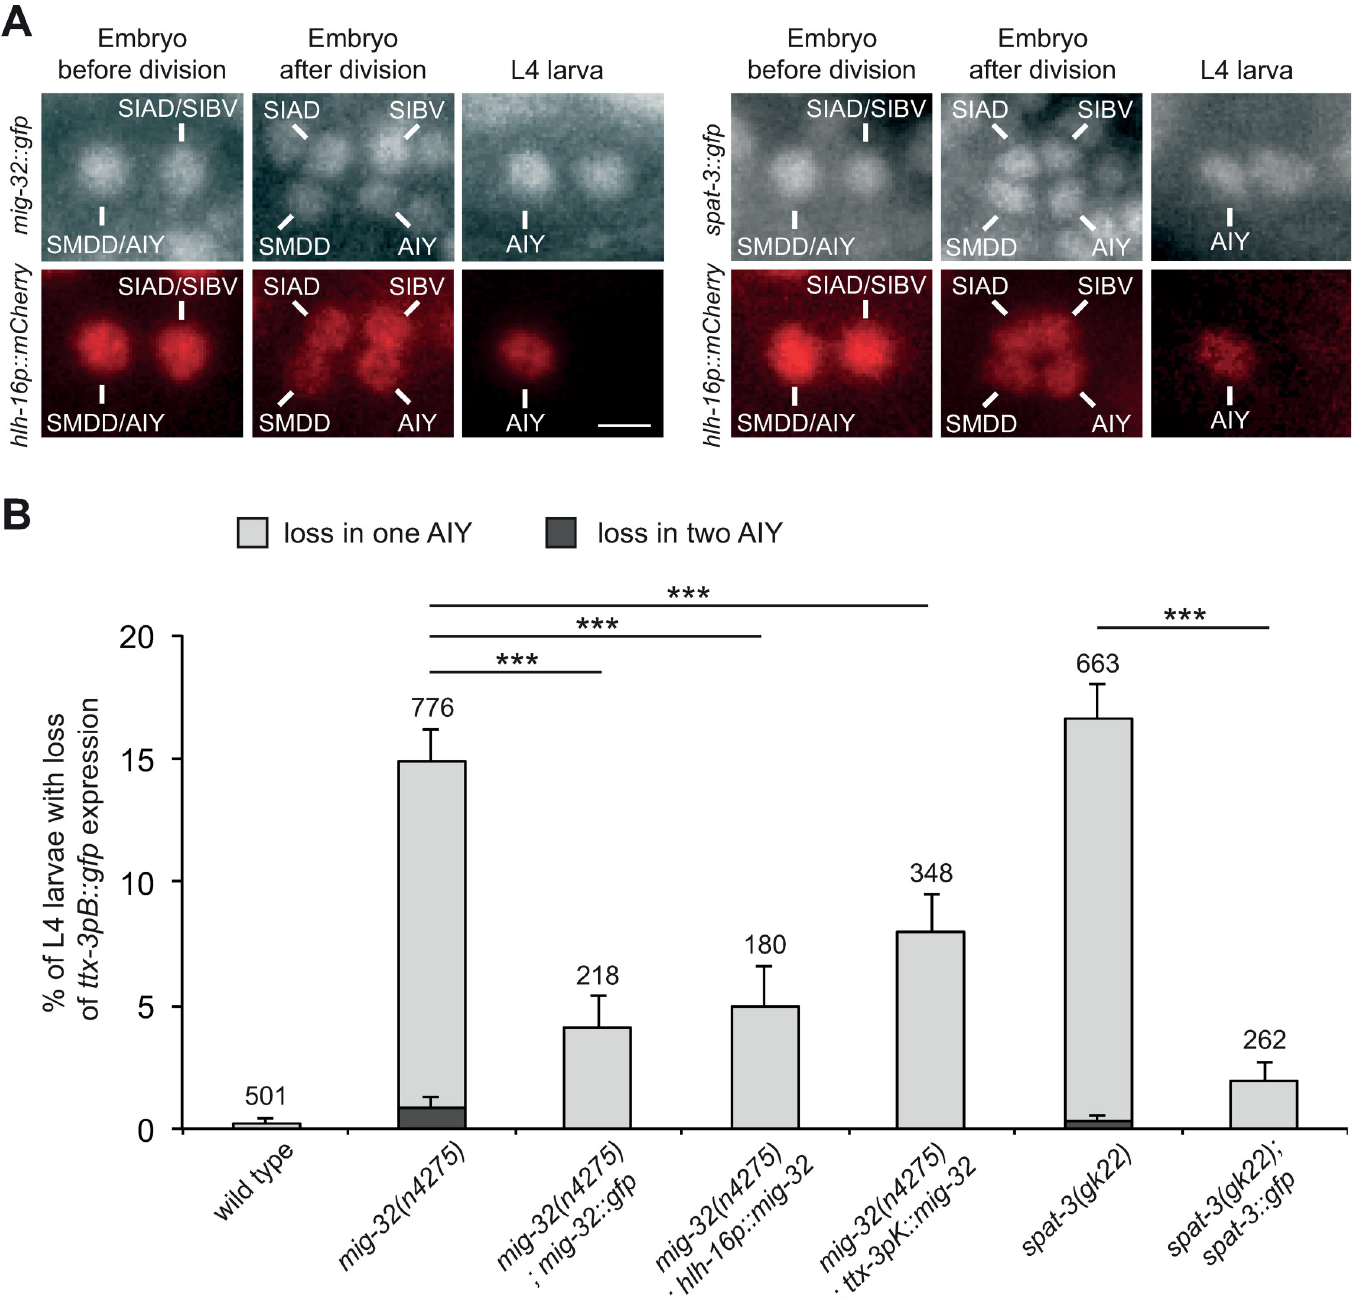
Fig 6. Expression of the PRC1 factors and cell-specific rescue. (A) Expression of mig-32 :: gfp (fosmid based translational fusion, vbaIs44 ) and spat-3 :: gfp (fosmid based translational fusion, vbaIs47 ) in the AIY lineage labeled with hlh-16p :: mCherry ( hlh-16 promoter driving the expression of a nuclear mCherry). In the embryo, MIG-32 and SPAT-3 are detected in the SMDD/AIY mother cell and its sister cell, the SIAD/SIBV mother cell, before their terminal division. Following the terminal division, MIG-32 and SPAT-3 are detected in the newly generated SMDD, AIY, SIAD and SIBV neurons. In L4 larvae, MIG-32 and SPAT-3 are detected in the AIY neuron. Scale bar = 2 μ m. (B) Percentage of L4 larvae that display a loss of ttx-3pB :: gfp ( otIs173 ) expression in one (grey bar) or two (black bar) AIY neurons (error bars show standard error of proportion, numbers above the bars show number of animals analyzed). The transgenes mig-32 :: gfp (fosmid based translational fusion, vbaIs44 ), hlh-16p :: mig-32 ( vbaEx158 ), ttx-3pK :: mig-32 ( vbaEx155 ) and spat-3 :: gfp (fosmid based translational fusion, vbaEx127 ) rescue the respective mutant ( ��� p < 0.002, Fisher’s exact